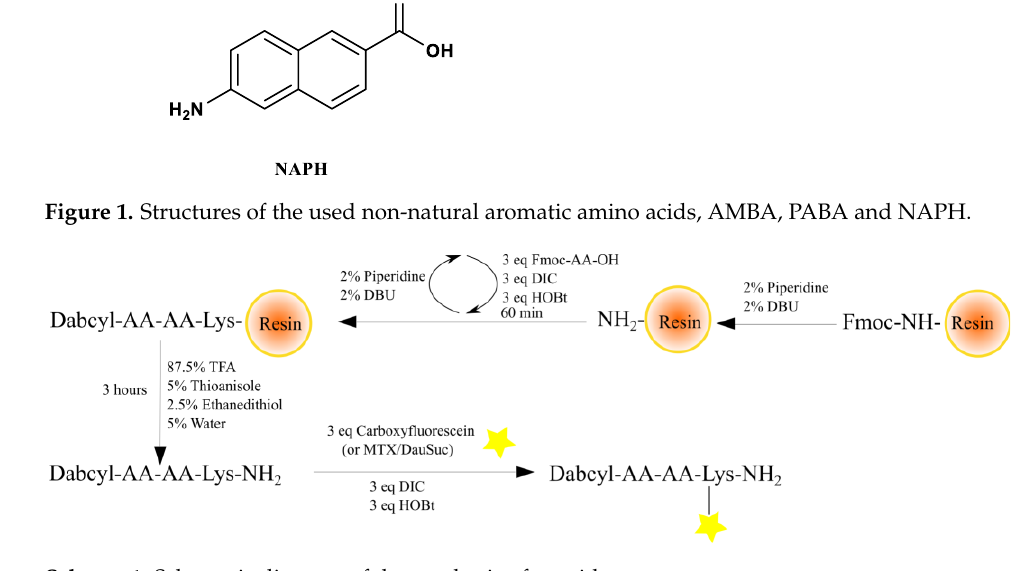
Scheme 1. Schematic diagram of the synthesis of peptides. Table 1. Chemical characterization of peptide